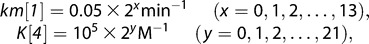
Sensitivity of the Total DnaK to the Change in the Transcription Rate Constant for DnaK at Low TemperatureThe plot reports the sensitivity computed for the parameters values that satisfy the required yield and efficiency (yield > 0.9 and efficiency > 0.85 at low and high temperature). Yield and efficiency were computed by searching the 2-D parameter space consisting of the transcription rate constant for σ32 and the association constant between σ32 and DnaK as follows:
for the various systems,
(A) DEG-FB/FF double mutant (SEQ-FB system): K[5] = K[6] = 0 M−1, kx[1] = kx[2] = 0 min−1, η = 1,(B) FF mutant (SEQ-FB + DEG-FB system): K[5] = K[6] = 1 × 108 M−1, kx[1] = kx[2] = 5 min−1, η = 1,(C) Wild-type (SEQ-FB +DEG-FB + FF system): K[5] = K[6] = 1 × 108 M−1, kx[1] = kx[2] = 5 min−1, η = 1 (low), η = 2 (high).